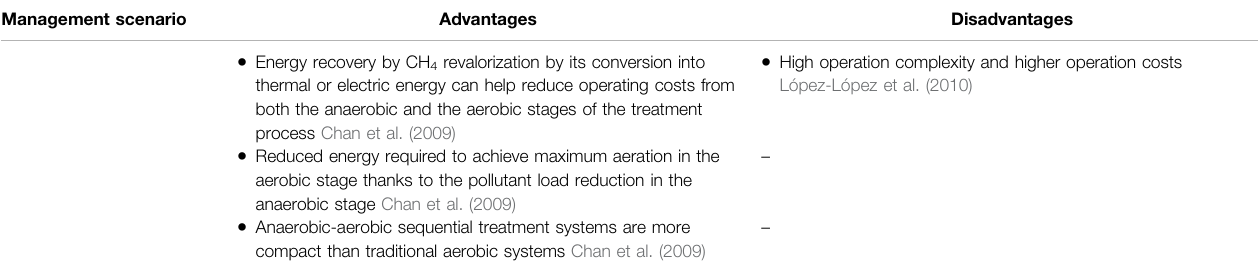
TABLE 10 | ( Continued ) Comparison between the advantages and disadvantages of the proposed vinasses management